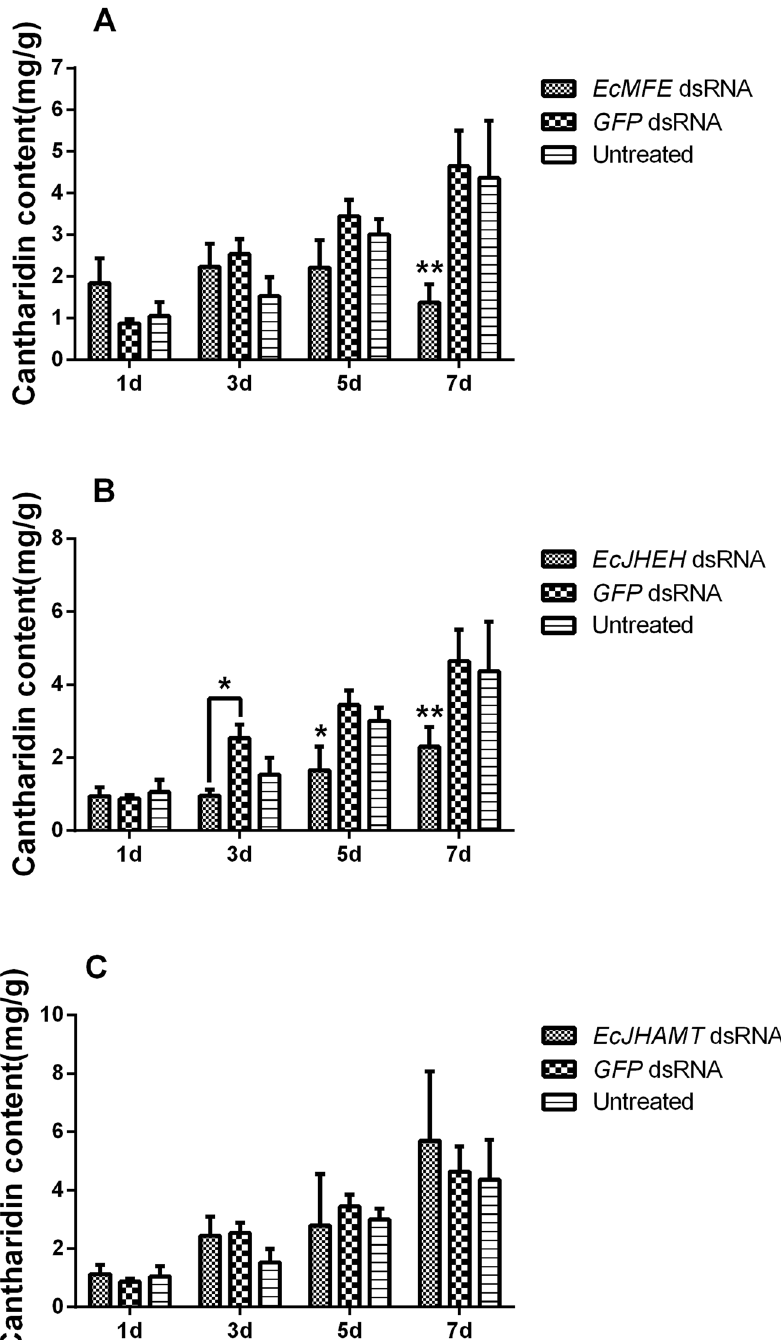
Figure 4. The cantharidin content in male E. chinensis at different times after dsRNA injection. ( A ) EcMFE . ( B ) EcJHEH . ( C ) EcJHAMT . Asterisks above represent statistically significant differences by Student’s t -test ( * P < 0.05; ** P ≤